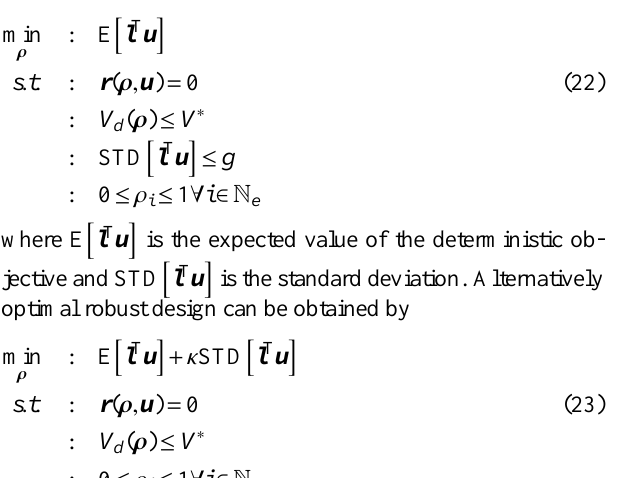
Fig. 4. The three projections are called eroded, intermedi- ate and dilated (Sigmund, 2009; Wang et al., 2011). If the intermediate projection is considered to be the reference de- sign, uniform over-etching error can be modelled by the